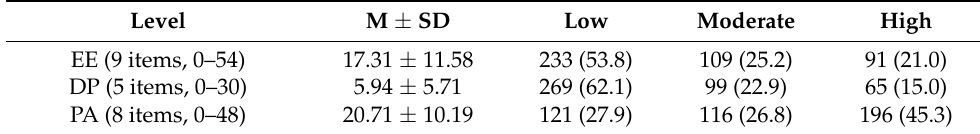
Table 1. Describing dimensions of job burnout in hospital administrators.